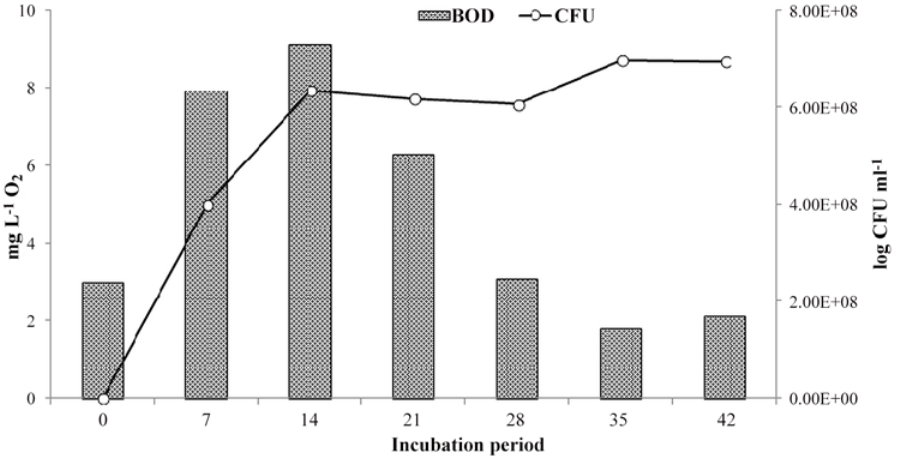
Fig 6. The relation between total bacterial population and BOD.